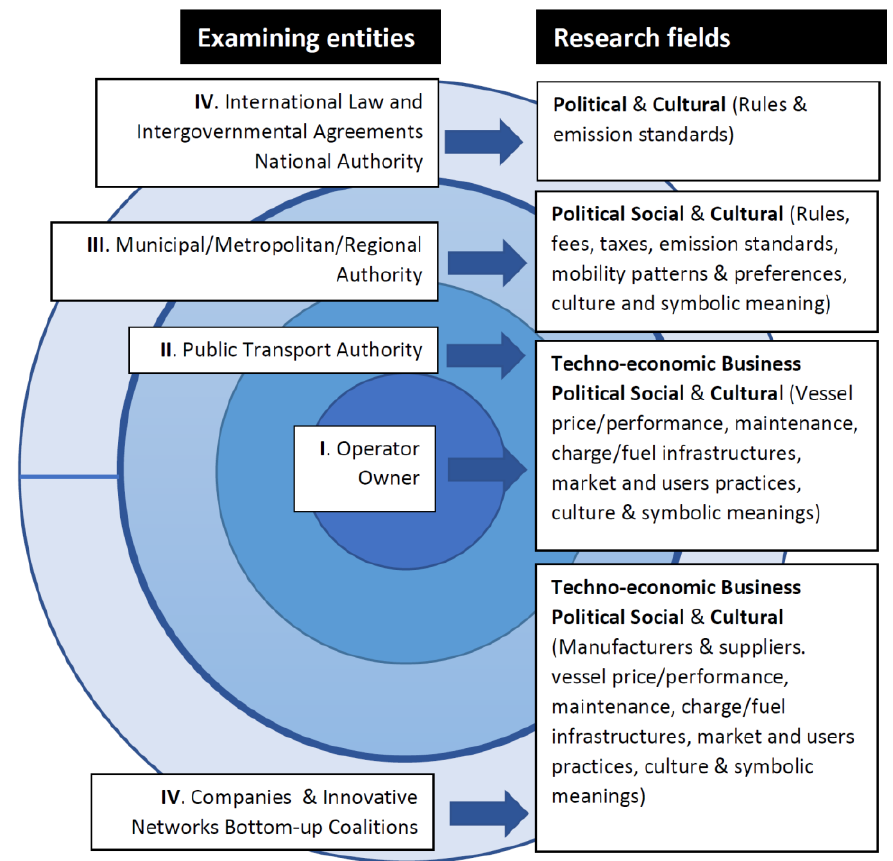
Figure 3. Stages of the research procedure.